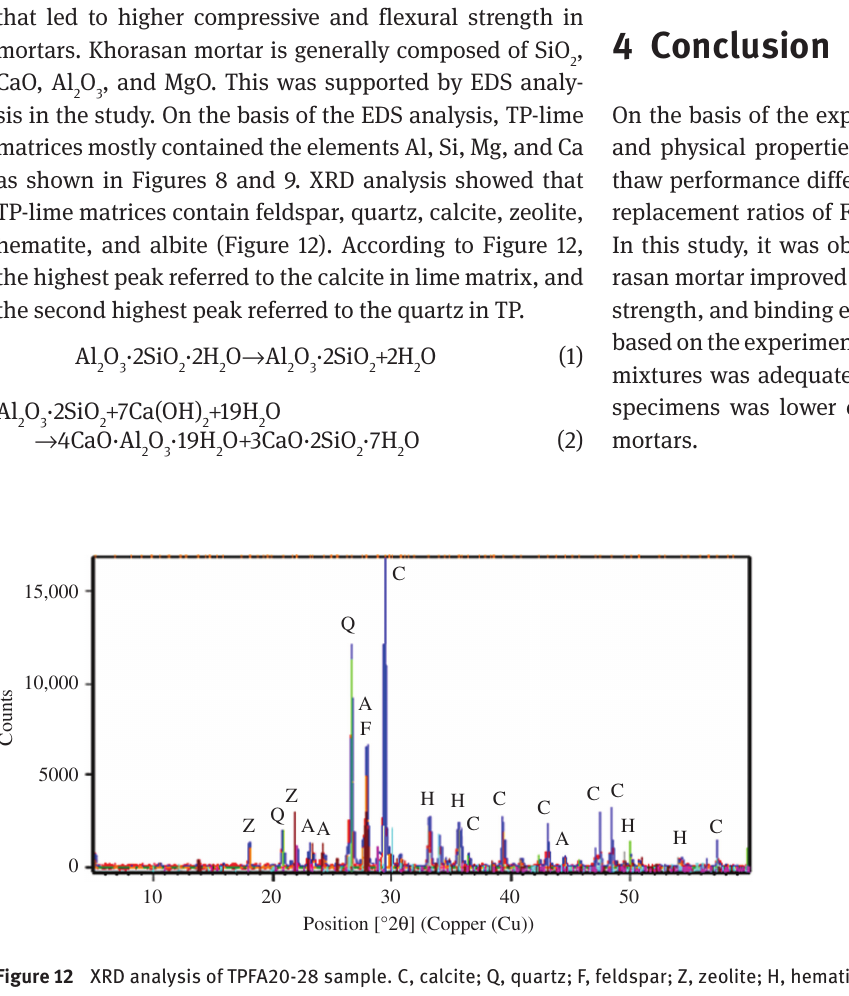
Figure 12 XRD analysis of TPFA20-28 sample. C, calcite; Q, quartz; F, feldspar; Z, zeolite; H, hematite; A,